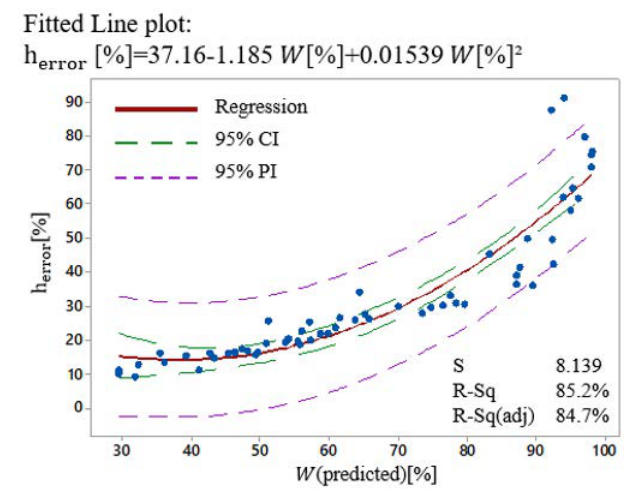
Figure 9. Correlation fitted line plots between height error ( h error (%)) and surface waviness ( W